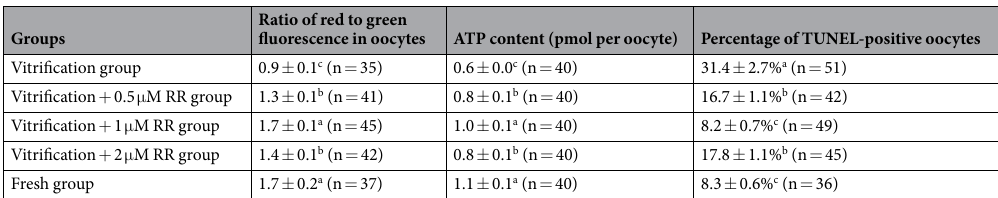
Table 4. Effect of RR treatment on the ratio of red to green fluorescence intensity, ATP content, and apoptosis of vitrified bovine oocytes. a,b,c Values with different superscripts differ significantly within the same column ( P <